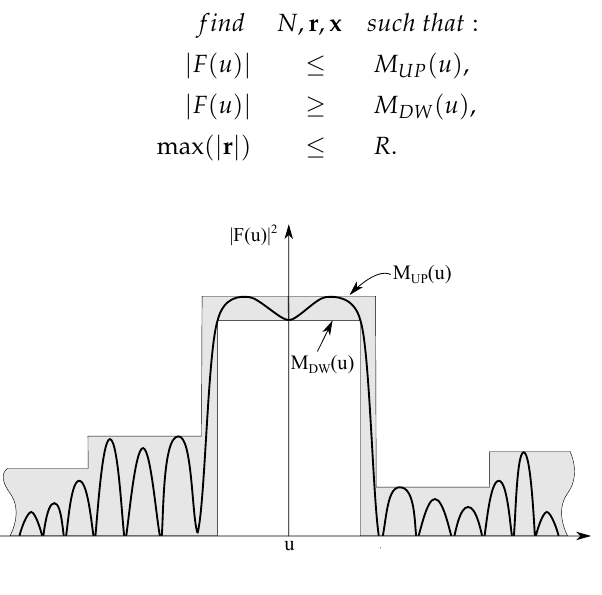
Figure 4. Power pattern